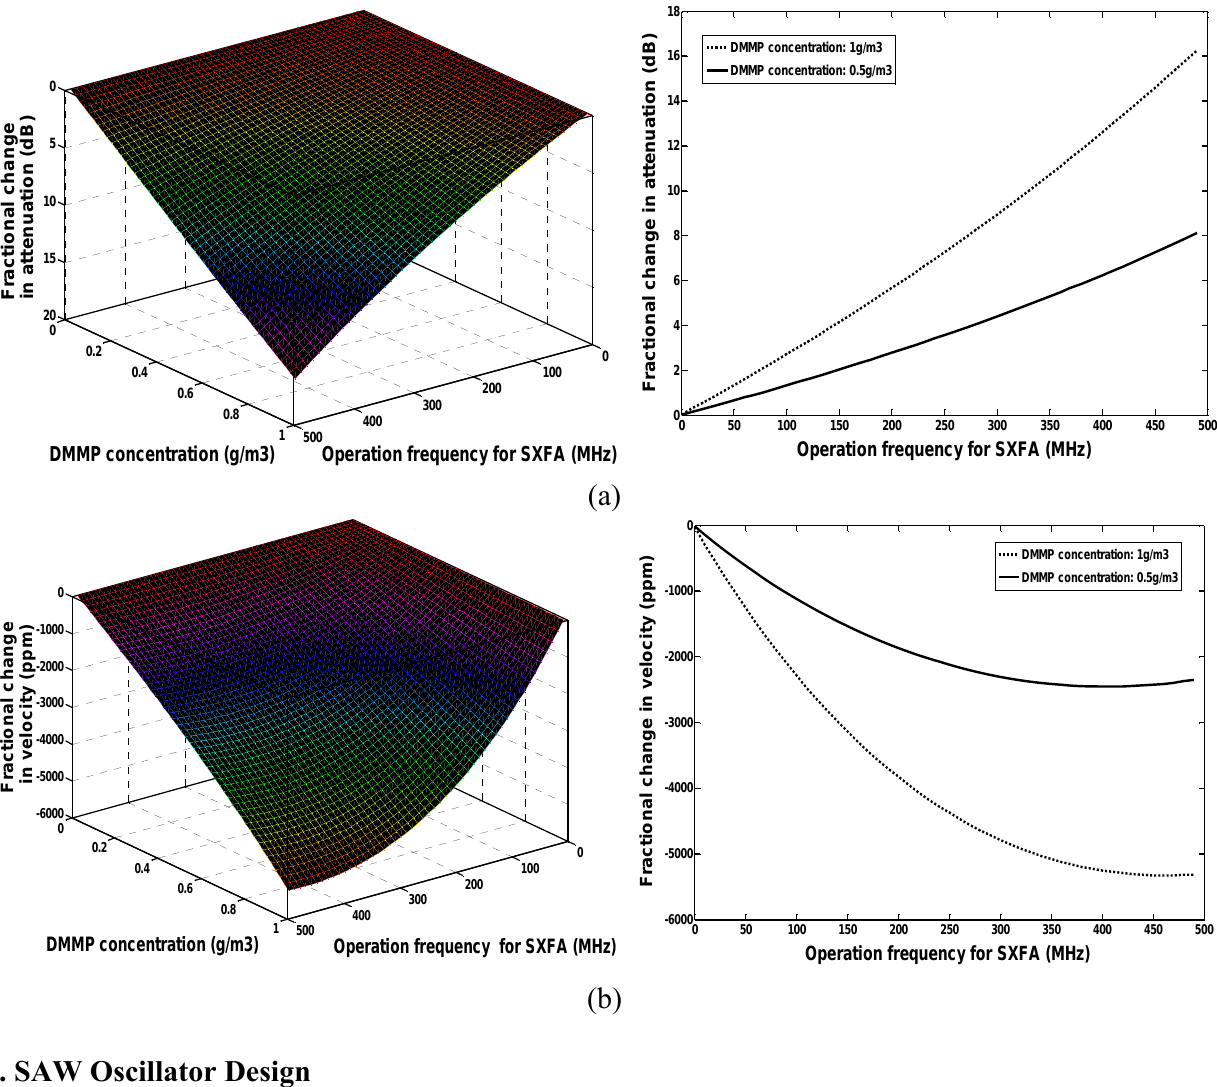
Figure 4. (a) Change in attenuation, and (b) velocity shift from frequency